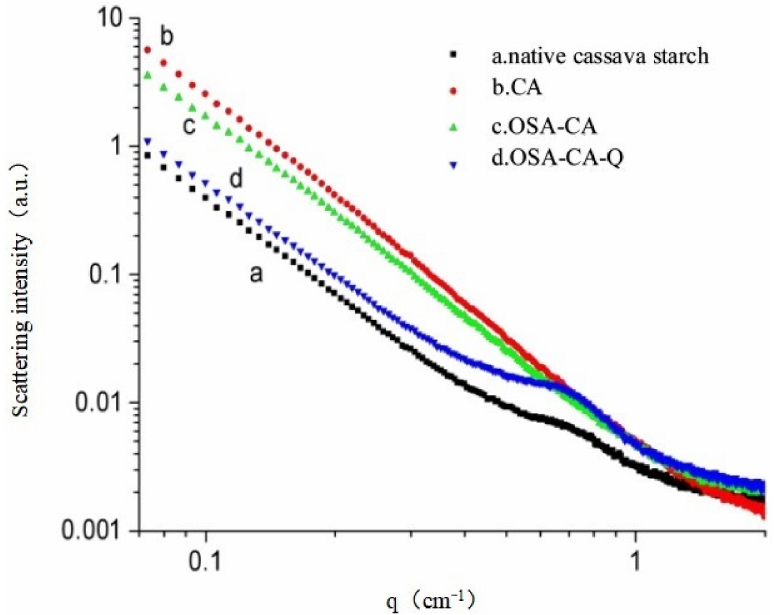
Figure 2. X-ray scattering curve. ( a ) native cassava starch; ( b ) CA; ( c ) OSA-CA; ( d ) OSA-CA/Q.